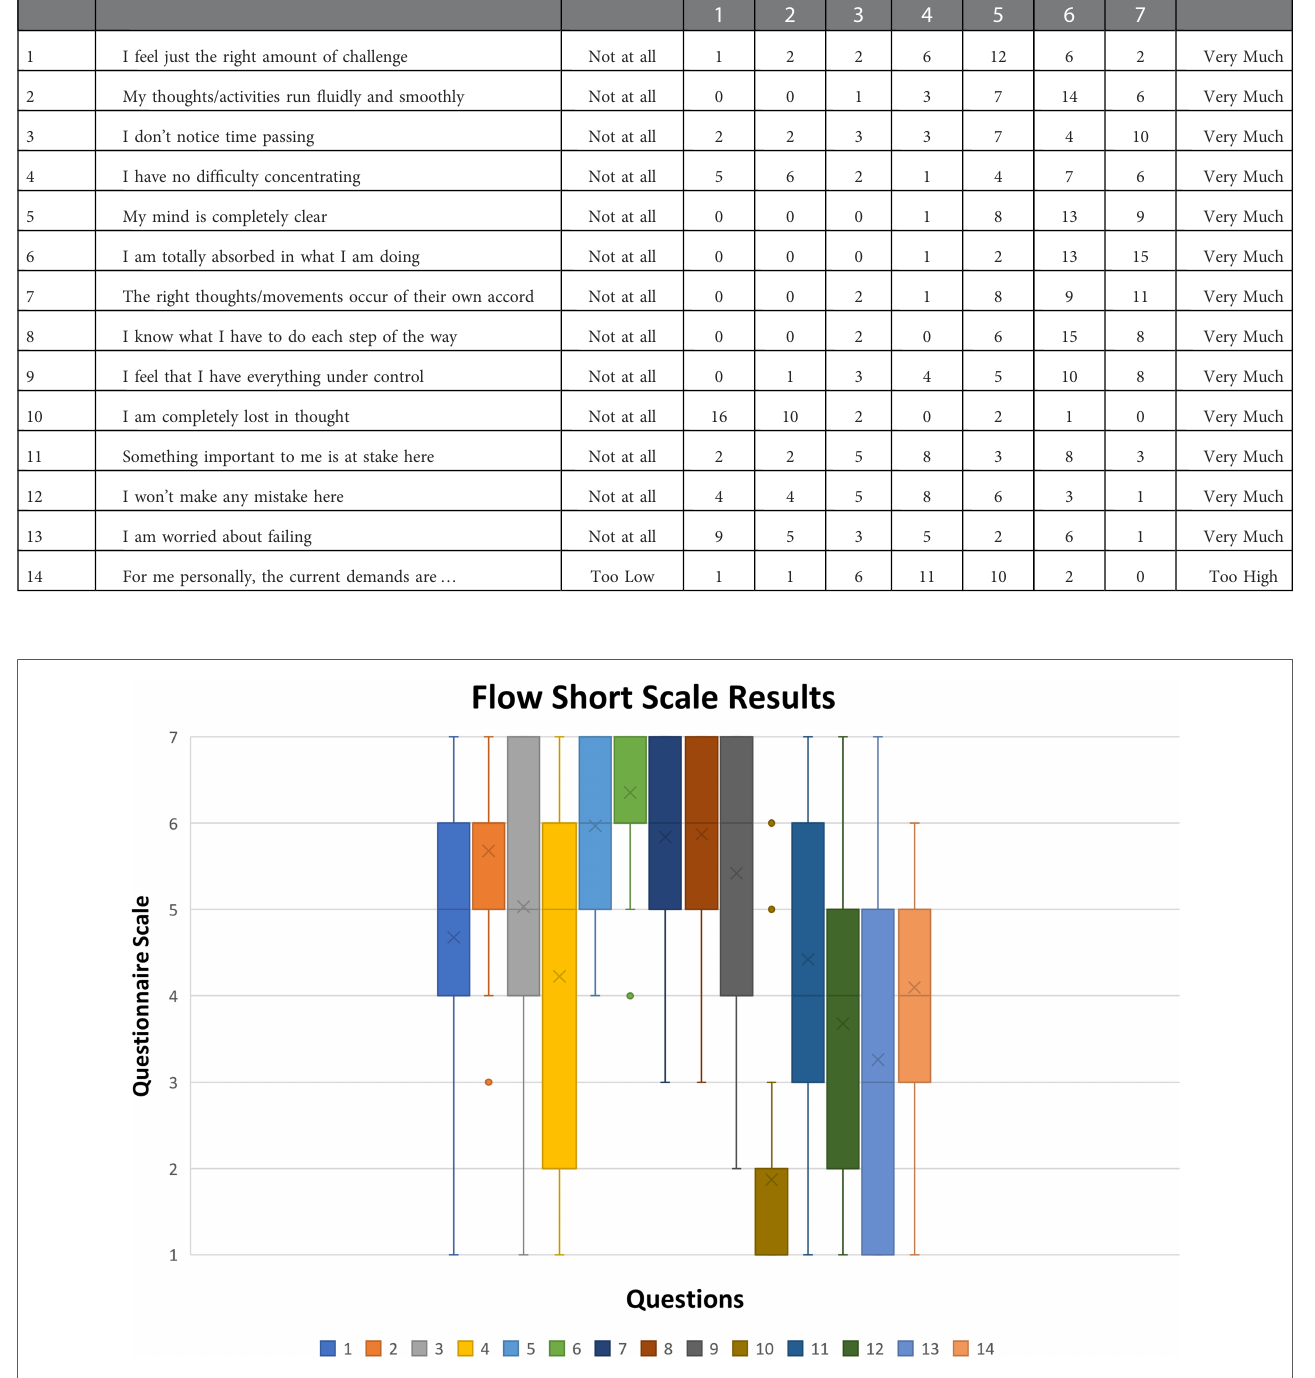
FIGURE 9 Boxplot chart of fl ow short scale results (x stands for mean value, rectangle upper and lower quartile with at least 50% of values, whiskers represent the 0th and fourth quartile when there are